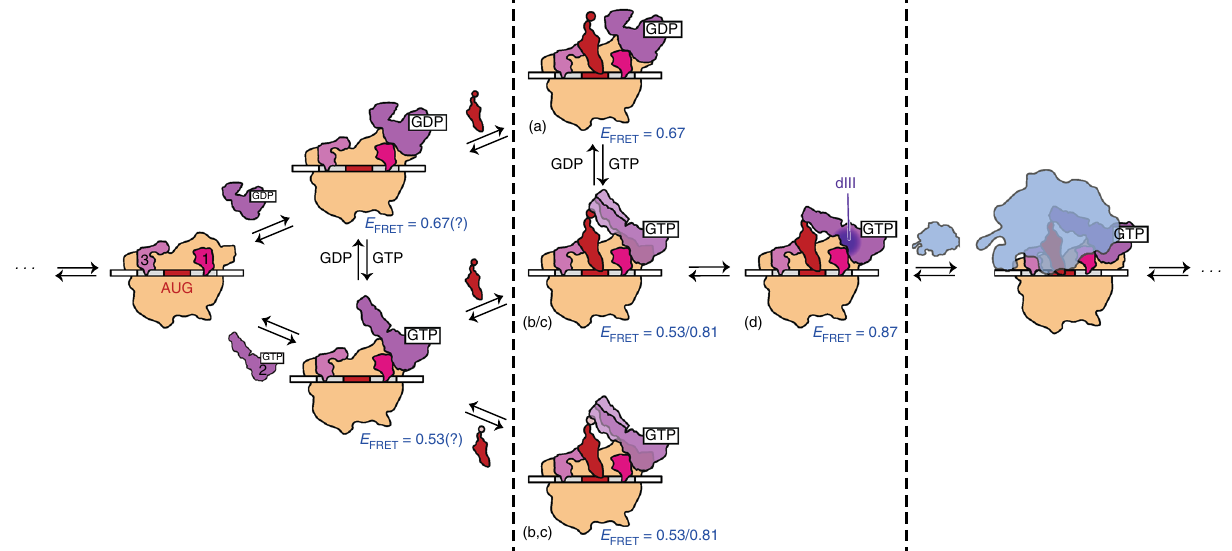
Fig. 5 Structural model for the GTP and fMet-tRNA fMet -dependent activation of 30S IC-bound IF2. 30S IC-bound IF2 can occupy at least four distinct conformational states relative to the P-site tRNA (denoted as conformations a – d ). These conformational states are characterized by E FRET values of 0.67 ( a ), 0.53 ( b ), 0.81 ( c ), and 0.87 ( d ). The dotted box highlights 30S ICs and pseudo 30S ICs studied in this work and their corresponding E FRET values. 30S ICs and E FRET values indicated outside of the dotted box are predicted conformational states of IF2. (Central panel) The speci fi c binding of GTP to dI of IF2 is allosterically communicated through dIII and results in a repositioning of dIV closer to the P site of the 30S IC and further from dI-III. The speci fi c recognition of the N -formyl-methionine of a P-site-bound fMet-tRNA fMet by dIV of IF2(GTP) feeds back to dIII (dark purple), thereby stabilizing a conformation of dI-dIII of IF2 that is active for rapid 50S subunit joining. In contrast, (top panel) the binding of GDP to dI of IF2, or (bottom panel) the presence of an unformylated Met-tRNA fMet , or an elongator tRNA in the P site fails to stabilize the active conformation of IF2, instead leaving IF2 in a conformation(s) that are inactive for rapid 50S subunit